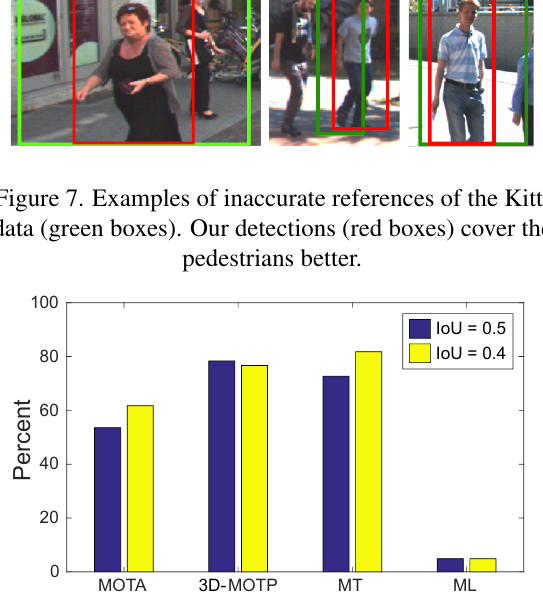
Figure 8. Performance of our tracker in 3D object space with different IoU thresholds.